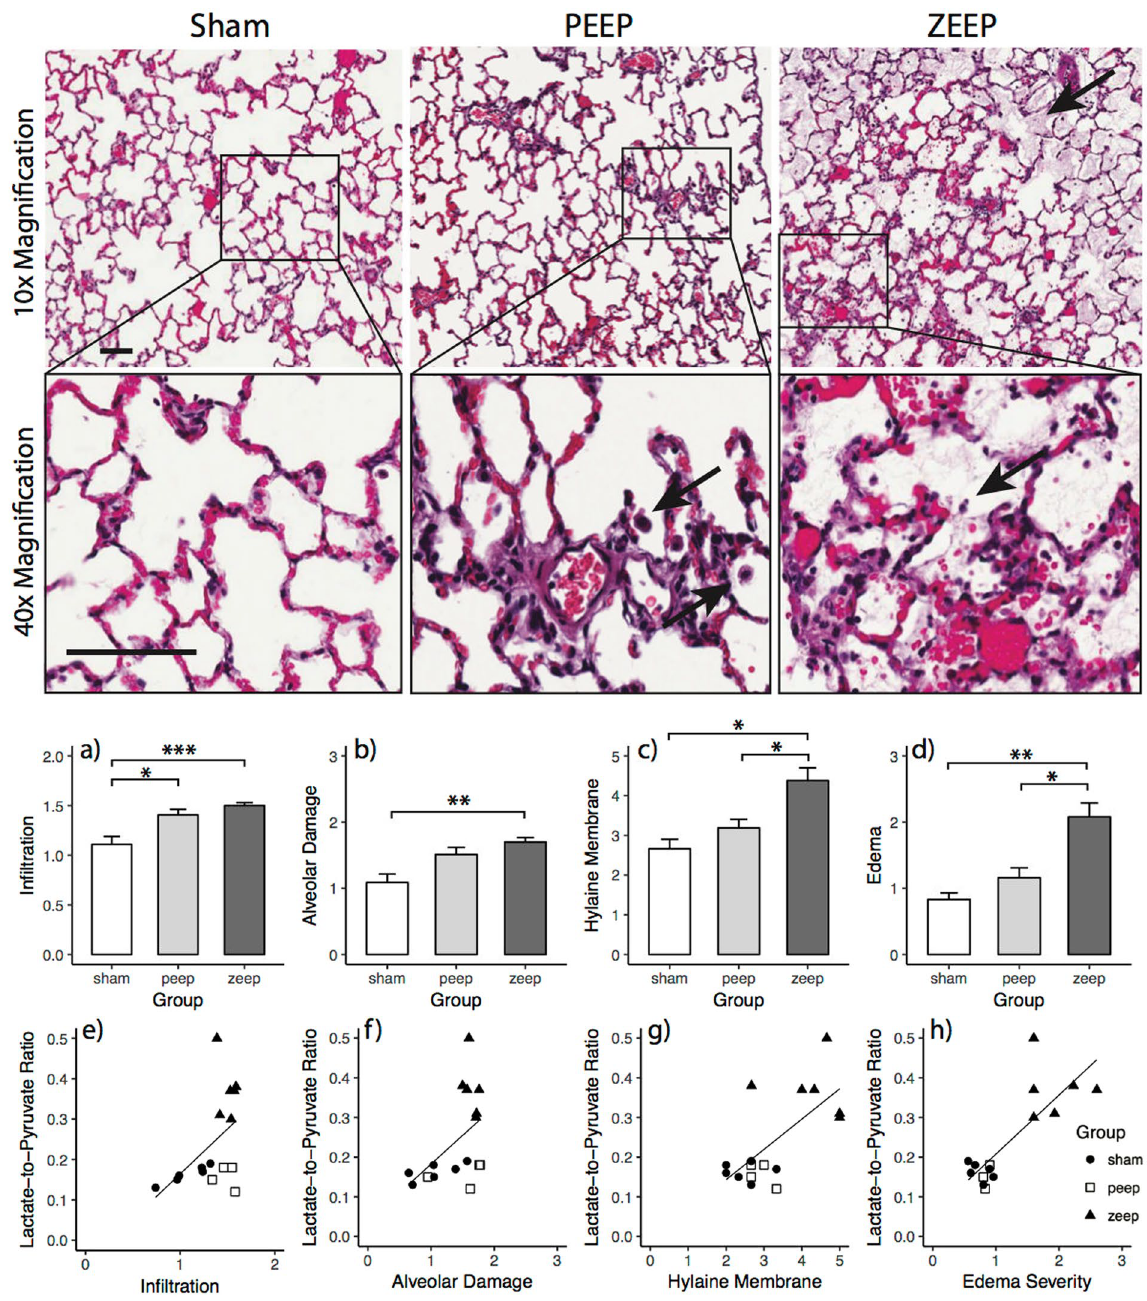
Figure 5. (Top) Hematoxylin and Eosin (H&E) stained lung sections of rats from each group. Representative images shown are at 10 × and 40 × . In ZEEP lungs, arrows show the presence of fluid within the alveolar space. Solid arrows delineate infiltrates and debris. In lungs subjected to PEEP, alveolar structure is more intact. Infiltrates are shown by solid arrows. The scale bar is 100 µ m. (Middle) Average injury scores for various morphological features for different groups. ANOVA showed a significant difference among groups (infiltration: χ 2 (2) = 11.273, p = 0.003, alveolar damage: χ 2 (2) = 10.000, p = 0.007, hyaline membrane deposition: χ 2 (2) = 10.678, p = 0.005 and edema: χ 2 (2) = 12.154, p = 0.002). Infiltration ( a ) and alveolar damage scores ( b ) were significantly higher in the ZEEP group than in the sham group ( p = 0.001, p = 0.012), while infiltration was significantly higher in the ZEEP group than the PEEP group ( p = 0.035). Hyaline membrane deposition ( c ) and edema severity ( e ) were both significantly higher in the ZEEP group relative to the PEEP ( p = 0.048, p = 0.041) and sham ( p = 0.014, p = 0.006) groups. (Bottom) Among the histological features, hyaline membrane deposition ( r = 0.612, p = 0.003) ( g ) and edema severity ( r = 0.663, p = 0.001) ( h ) were strongly correlated with lactate-to-pyruvate ratio. ( * p < 0.05, ** p < 0.01, *** p <